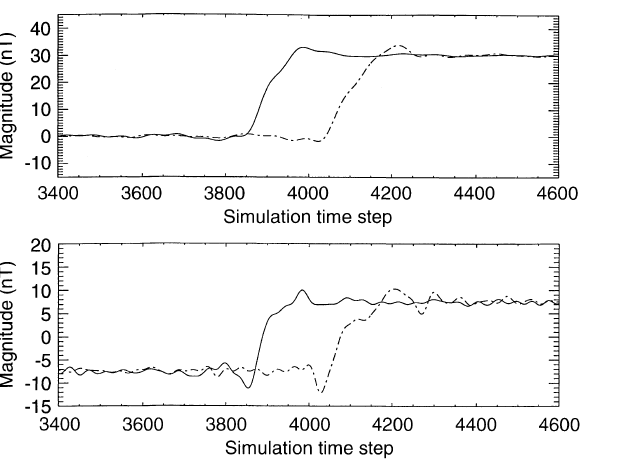
Fig. 10. The upper plot shows the low pass filtered time stationary component of the structure. The filter cut o(cid:128) frequencies higher than 35 D f . The abscissa corresponds to the simulation time step ~ t . The dash dotted line denotes the magnetic B ? component sampled by spacecraft 1, the solid line B ? sampled by spacecraft 2. The lower plot shows the band pass filtered (frequencies between 41–140 D f are kept) time evolving component of the structure. Again, the dash dotted line corresponds to